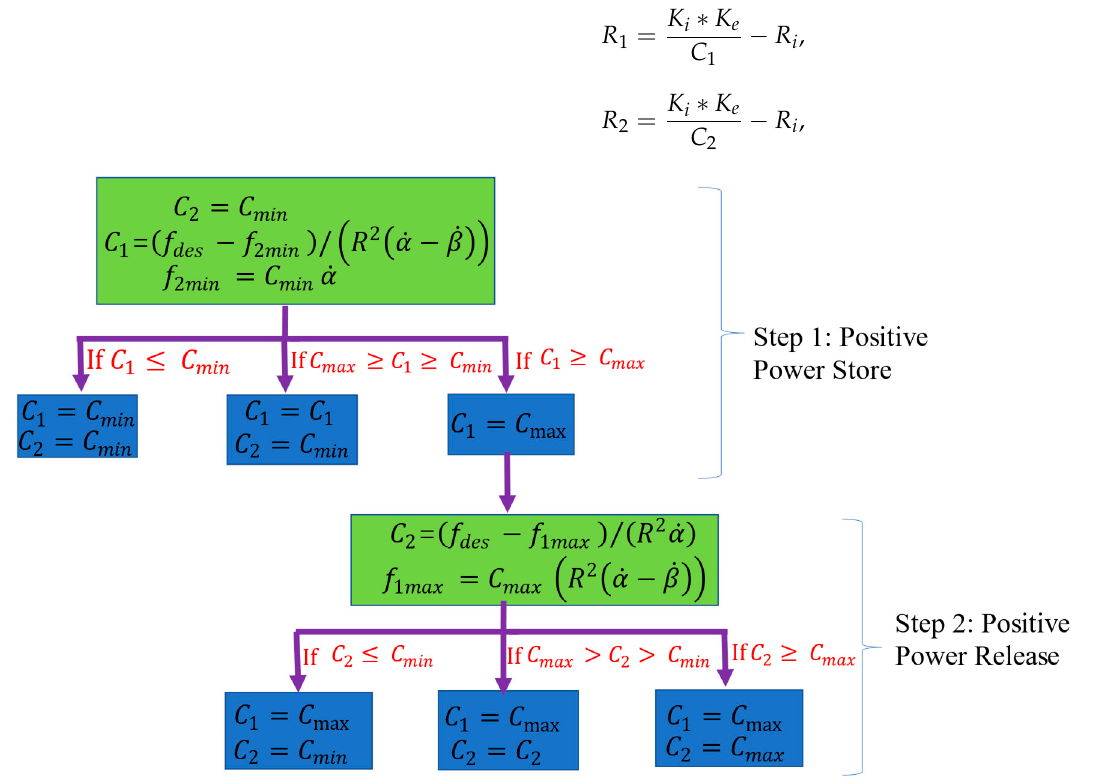
Figure 12. NEPS control